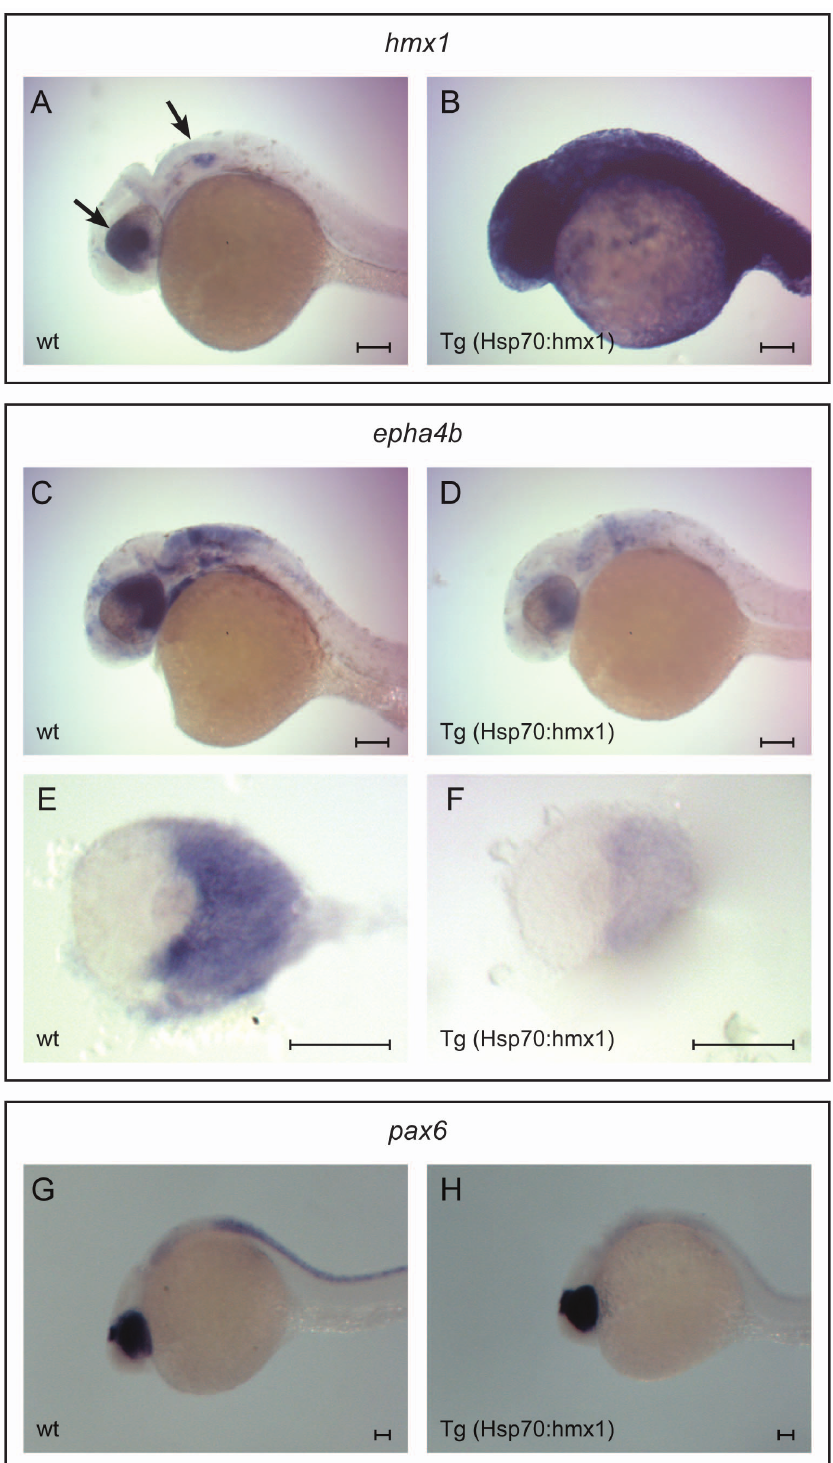
Figure 6. Regulation after hmx1 misexpression in zebrafish. Expression of hmx1 after heat shock in wt and tg (hsp70:hmx1) embryos (A, B). Hmx1 , normally restricted to the nasal retina, lens and ear (arrows in A), was broadly expressed in the transgenic embryo (B). Epha4b expression after heat shock in wt and Tg (hsp70:hmx1) embryos (C–F). Dissected eye showed a strong reduction of epha4b expression in the temporal retina when HMX1 was co-expressed (E, F). Pax6 regulation after HMX1 misexpression in zebrafish. Ocular expression of pax6 in wt (G) was not modified by overexpression of HMX1 in Tg(hsp70:hmx1) embryos (H). Scale bars: 100 m m.